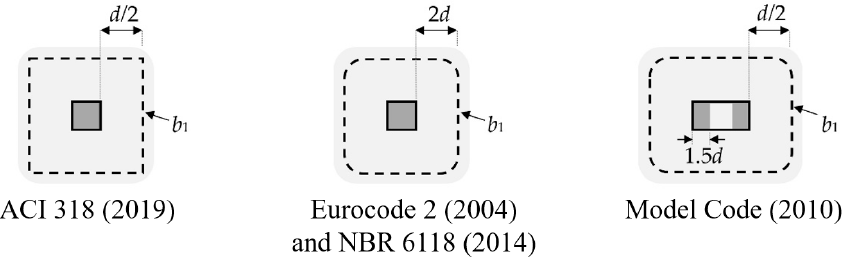
Figure A1. Perimeters for punching verification according to current codes [11–14].